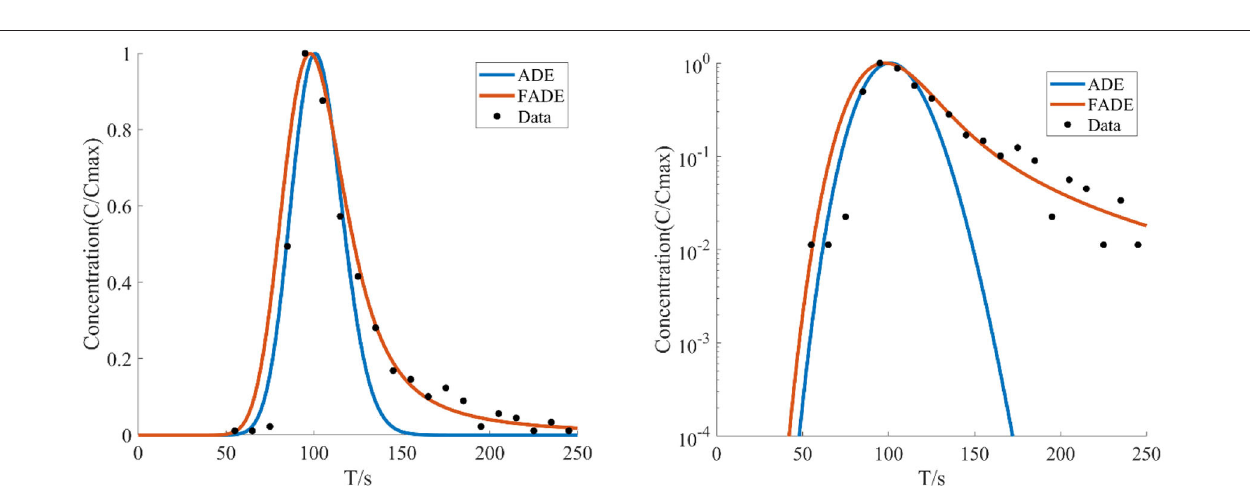
Frontiers in Physics |